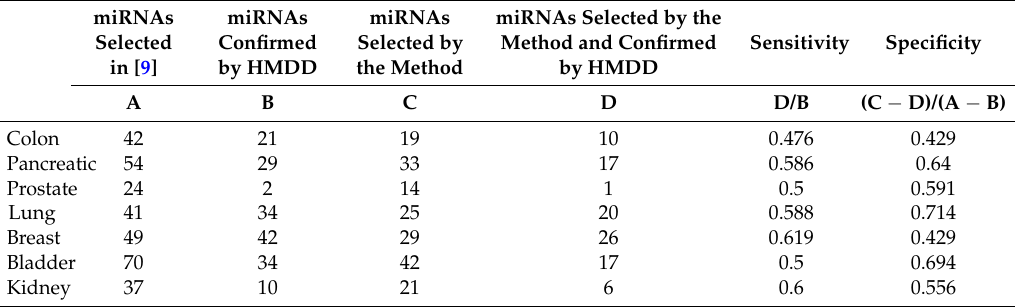
Table 2. Numbers of miRNA and the sensitivities and specificities of the proposed method. HMDD, Human MicroRNA Disease